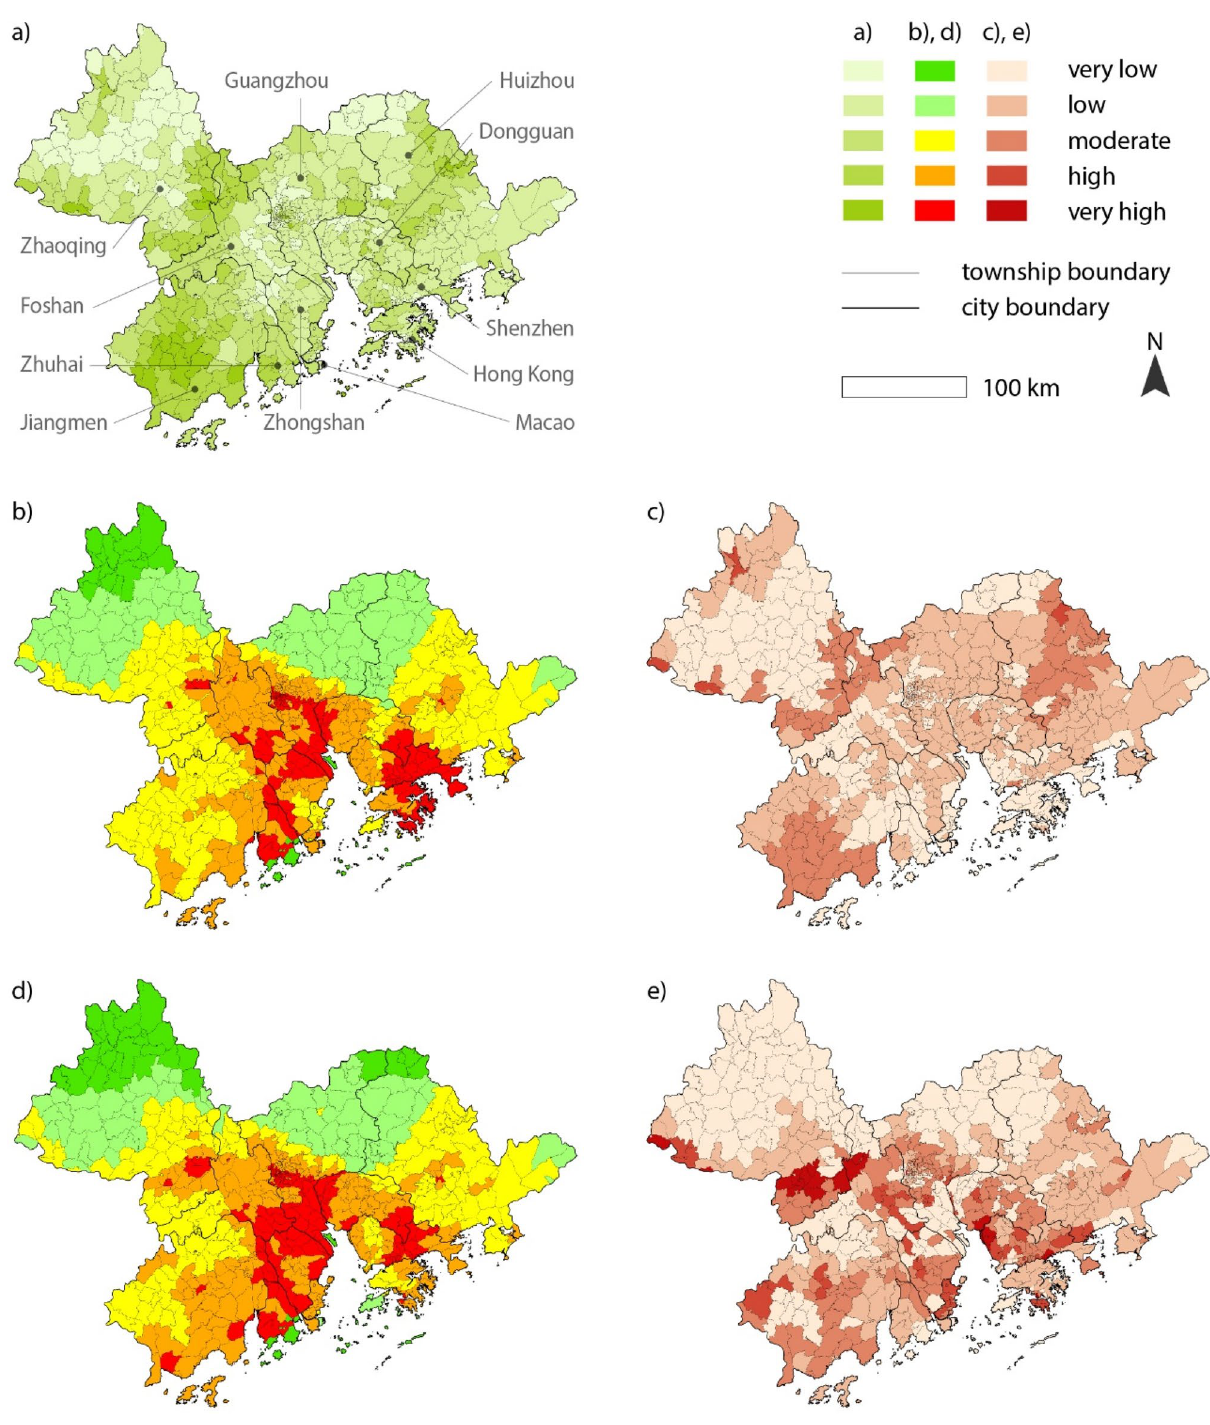
Figure 1. Impact-greenspace and vulnerability-greenspace index maps: ( a ) greenspace increase; ( b ) climate impacts; ( c ) impact-greenspace index; ( d ) climate vulnerability; and ( e ) vulnerability-greenspace index. Illustrated by authors using ArcMap software (Esri Inc. (2019). ArcMap 10.8, https:// www. esri. com/ en- us/